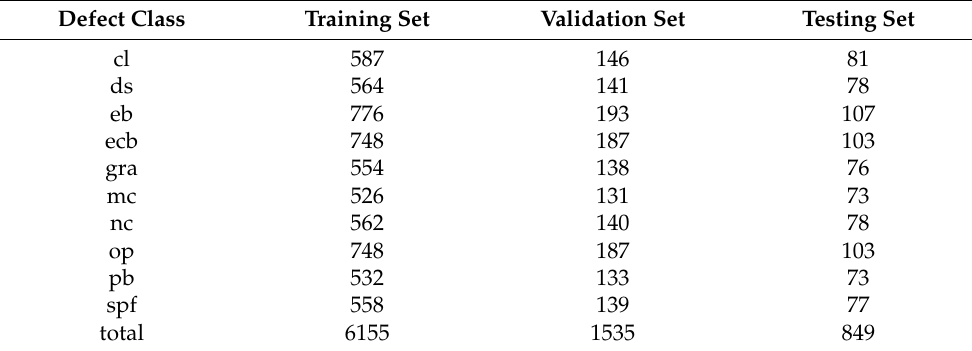
Table 4. The division of training set, validation set, and testing set